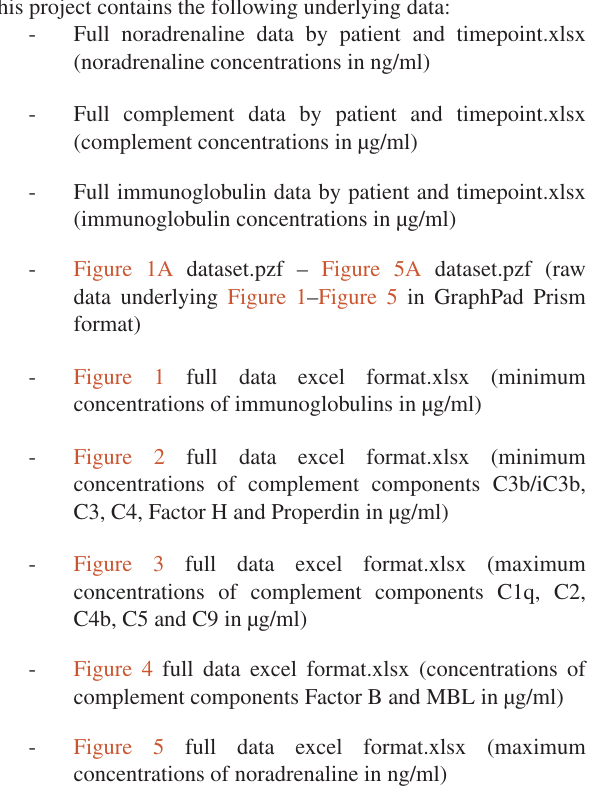
Figure 4 full data excel format.xlsx (concentrations of Figure 5 full data excel format.xlsx (maximum